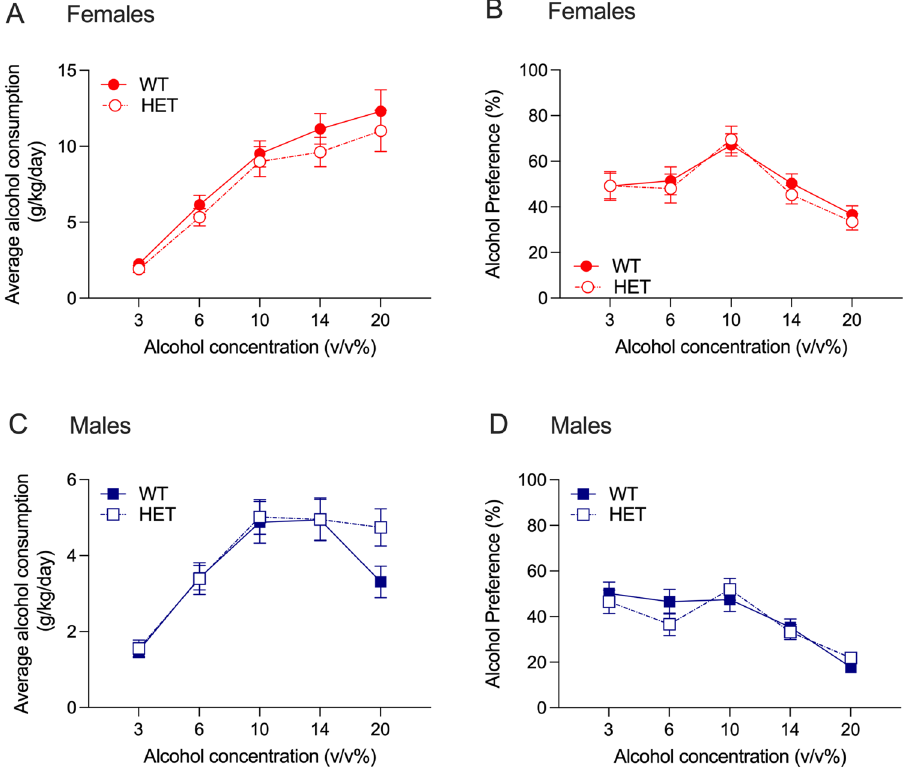
Figure 4. Alcohol consumption and preference in Slc39a8 WT and HET mice. No differences between Slc39a8 WT and HET mice were observed for ( A ) female alcohol consumption, ( B ) female alcohol preference, ( C ) male alcohol consumption and ( D ) male alcohol preference. Data are presented as mean ± SEM, n = 28 female mice per genotype, n = 32–33 male mice per